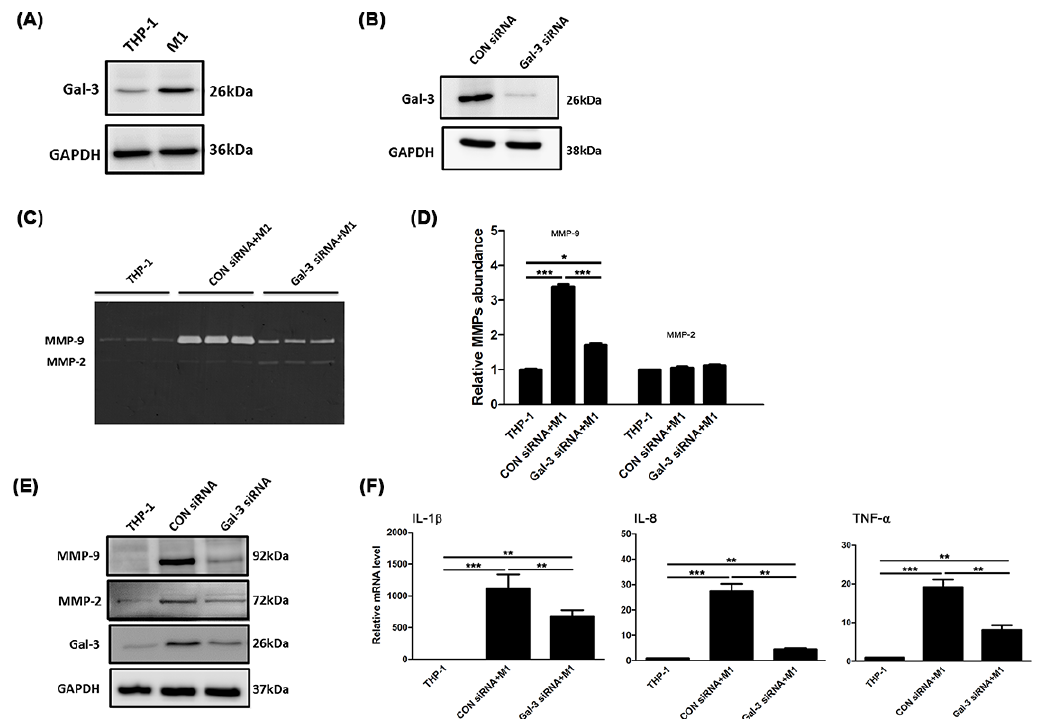
Figure 2. Gal-3 was involved in the modulation of inflammatory regulators in.macrophages. ( A ) THP-1 monocytes were stimulated with LPS and IFN-γ that were considered M1 macrophages. Gal-3 expression was analyzed using Western blots analysis. GAPDH was used as a loading control. The M1 cells exhibited increased Gal-3 expression. ( B ) Western blots analysis was used to detect the effect of Gal-3 expression knockdown by siRNA in M1 cells. ( C ) Gelatin zymography detected MMPs activity. The M1 macrophages markedly increased MMP-9 activity, which could be inhibited by Gal-3 blockade. ( D ) Histogram representing the quantified proteolytic activity. ( E ) The protein expression of MMP-9, MMP-2 and Gal-3 was confirmed by Western blots analysis. ( F ) Quantitative RT-PCR was performed to analyze IL-8, TNF- α , and IL-1 β mRNA expression. Data are expressed as mean ± S.E.M. for at least 3-4 independent experiments. * p < 0.05, ** p < 0.001, *** p < 0.0001.